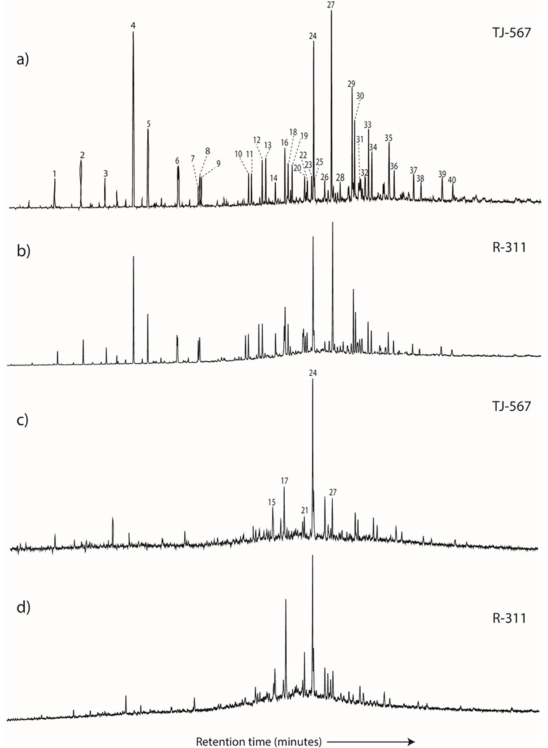
Figure 5. Examples of m / z 191 ( a , b ) and m / z 177 ( c , d ) ion chromatograms of the saturated fraction of representative TJ-567 and R-311